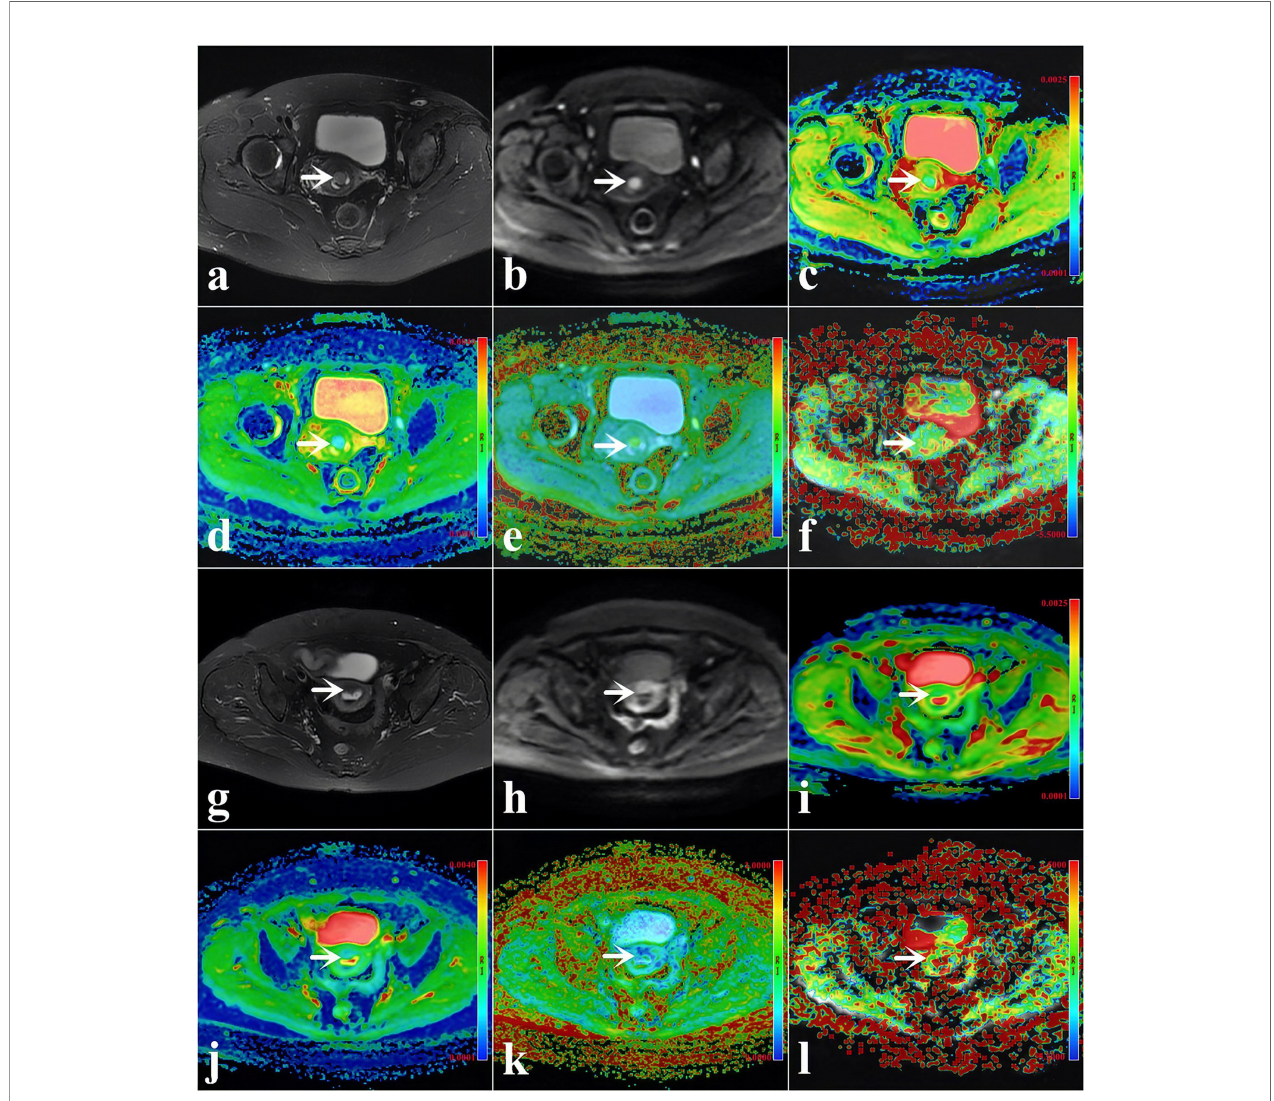
imaging (T2WI) maps (fat suppression). (B, H) Diffusion-weighted imaging (DWI) original maps ( b = 1,000 s/mm 2 ). (C, I) Pseudo-colored maps of the apparent diffusion coef fi cient (ADC). (D, J) Pseudo-colored maps of the mean diffusivity (MD). (E, K) Pseudo-colored maps of the mean kurtosis (MK). (F, L) Pseudo-colored maps of the magnetization transfer ratio asymmetry (MTRasym, at 3.5